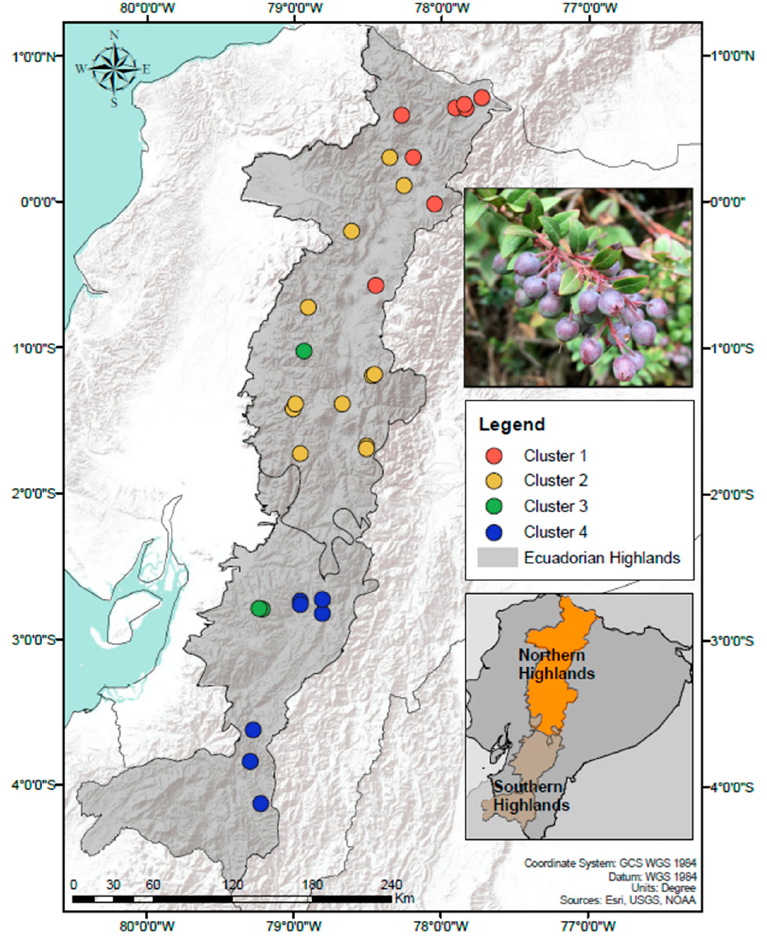
Figure 1. Sampling distribution of V. floribundum along the Ecuadorian Highlands.